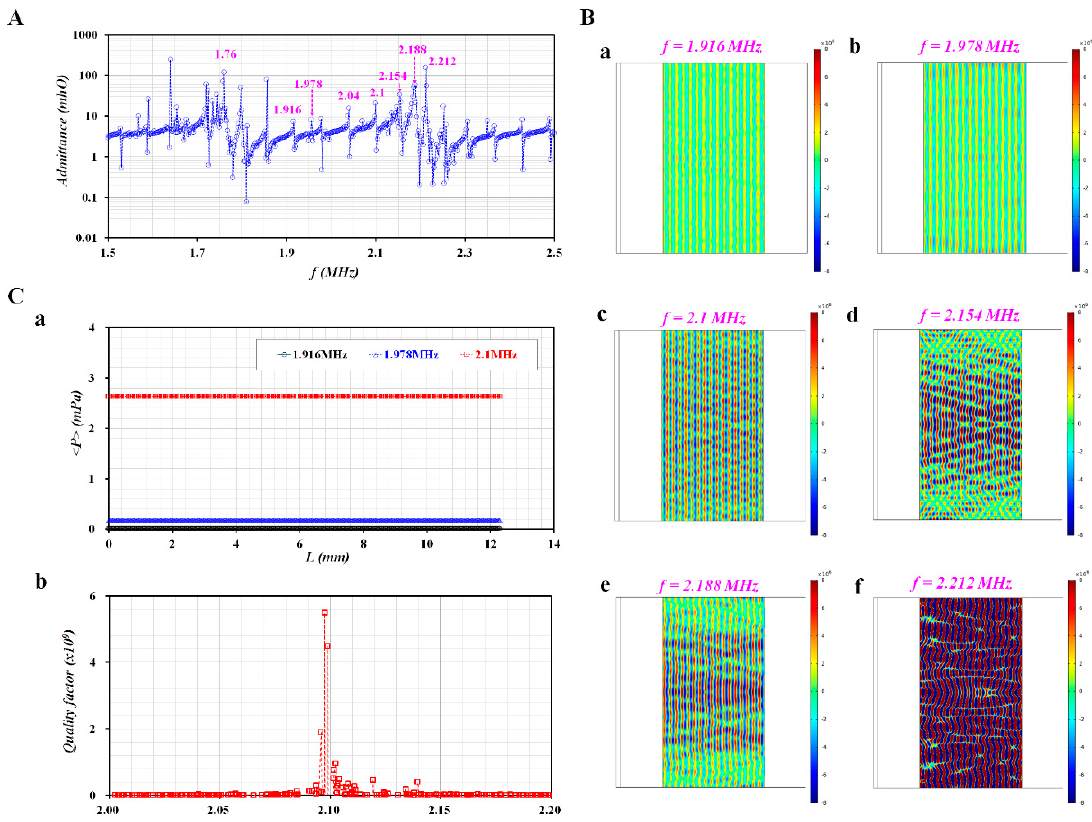
Figure 2. Numerical simulation of resonance frequency and acoustic pressure fields with respect to frequency. ( A ) Variations of admittance with respect to frequency for multilayer piezoelectric resonator. ( B ) Acoustic pressure fields at resonance frequency ( f ) (( a ) f = 1.916 MHz, ( b ) f = 1.978 MHz, ( c ) f = 2.1 MHZ, ( d ) f = 2.154 MHz, ( e ) f = 2.188 MHz, and ( g ) f = 2.212 MHz). ( C ) Variations of averaged acoustic pressure ( < P > ) and quality factor with respect to excitation frequency values ranging from f = 2 MHz to f = 2.2 MHZ. ( a ) Variation of < P > with respect to L and f = 1.916, 1.978, and 2.1 MHz. ( b ) Variations of quality factor with respect to